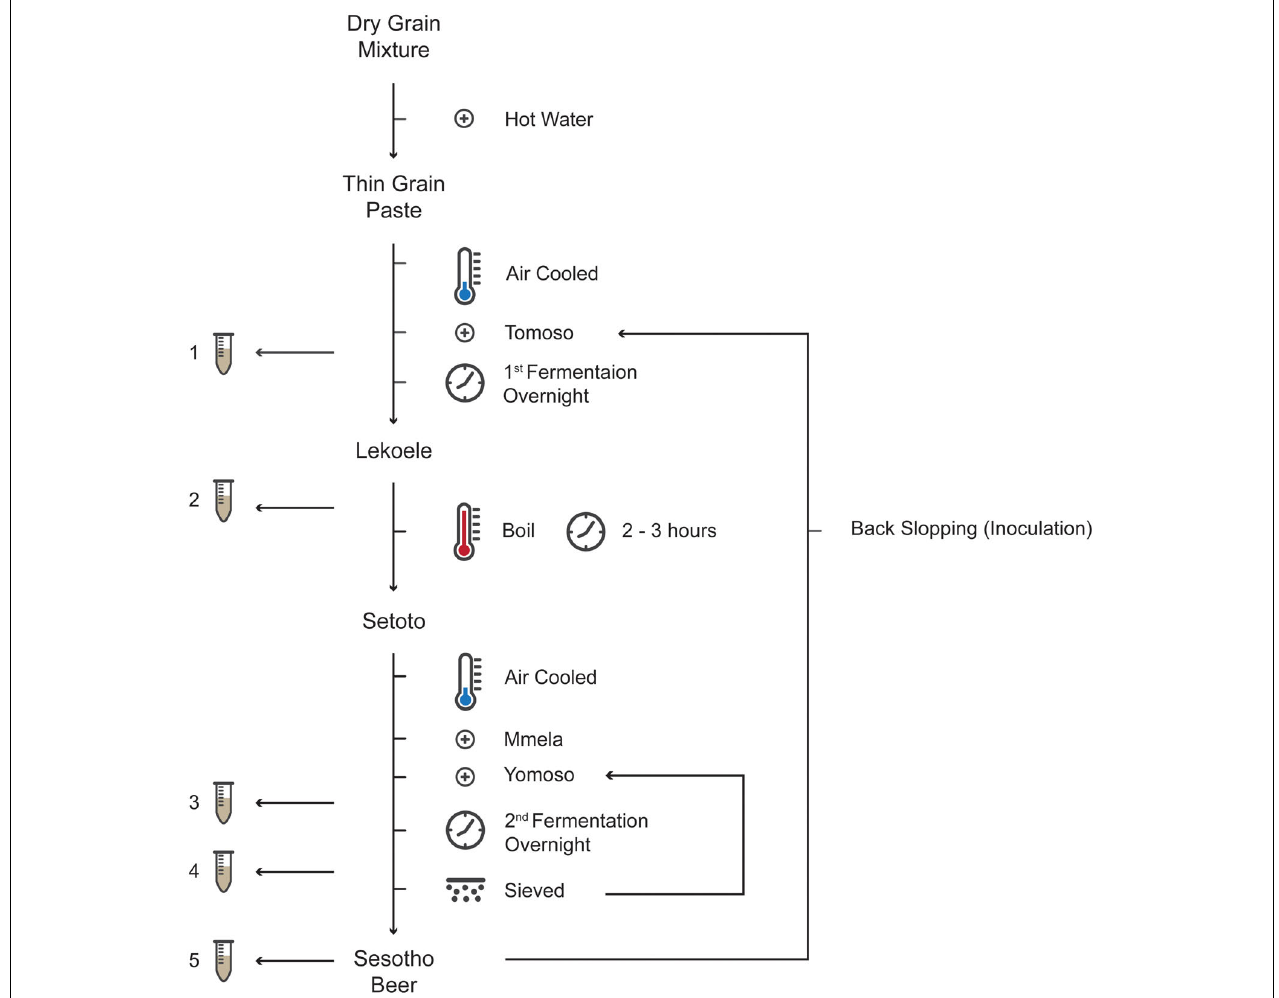
FIGURE 1 | A flow diagram of Sesotho preparation and sampling points